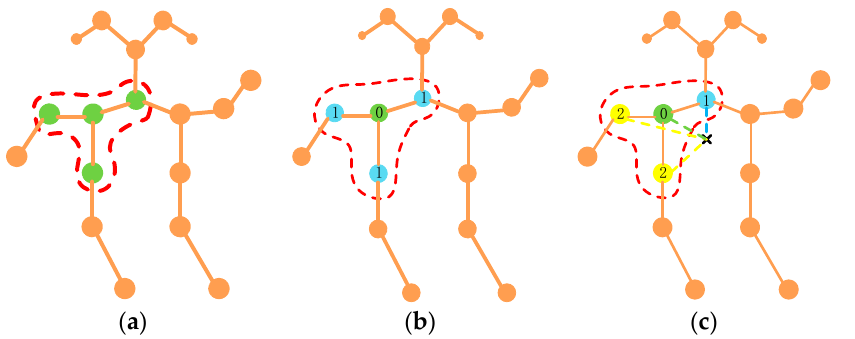
Figure 3. The way the sampling area is divided. ( a ) Unilabeling partitioning strategy. All nodes in the neighborhood have the same label (green); ( b ) distance partitioning strategy. These two subsets are the root node itself with a distance of 0 (green) and other adjacent points with a distance of 1 (blue).; ( c ) spatial configuration partitioning. Center of gravity of the skeleton (black cross), centripetal node (blue), and centrifugal node (yellow).